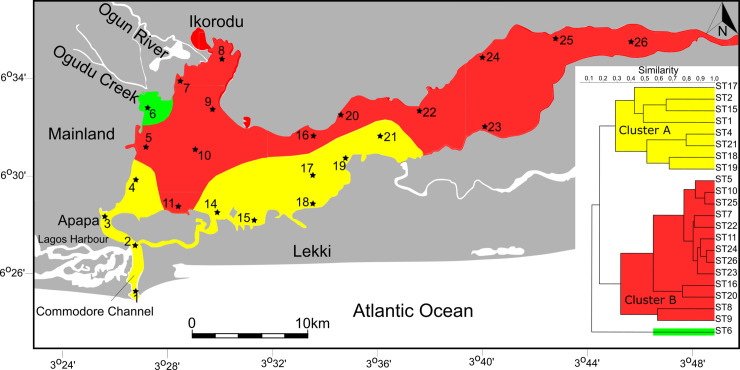
Q-mode cluster analysis and distribution of cluster groups across Lagos Lagoon.